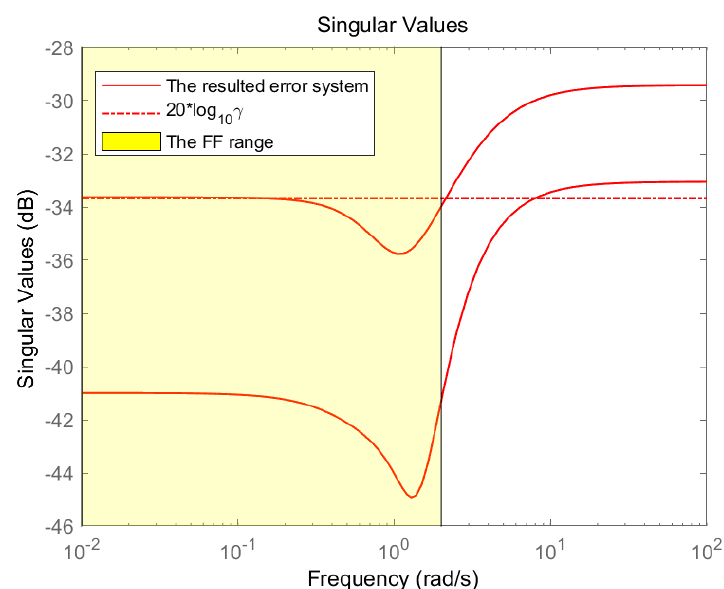
Figure 3. Singular value curves of the associated error